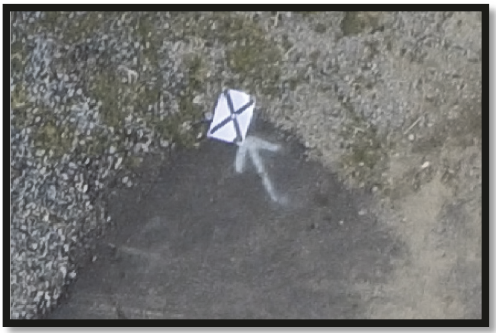
Figure 4: Premark for GCPs and